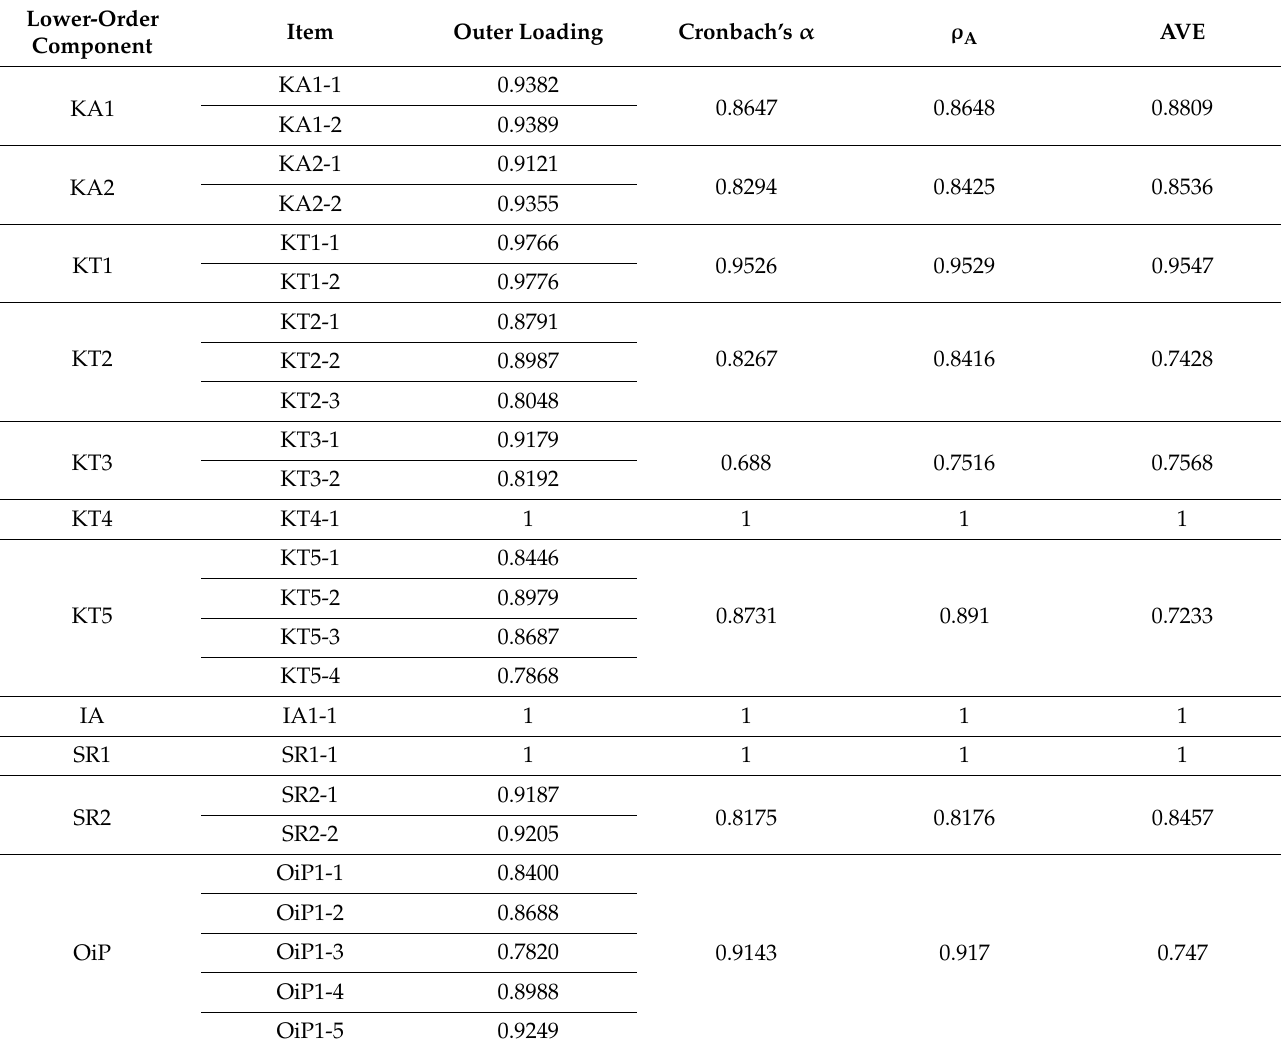
Table 2. Reliability and validity assessment of the path model in the initial